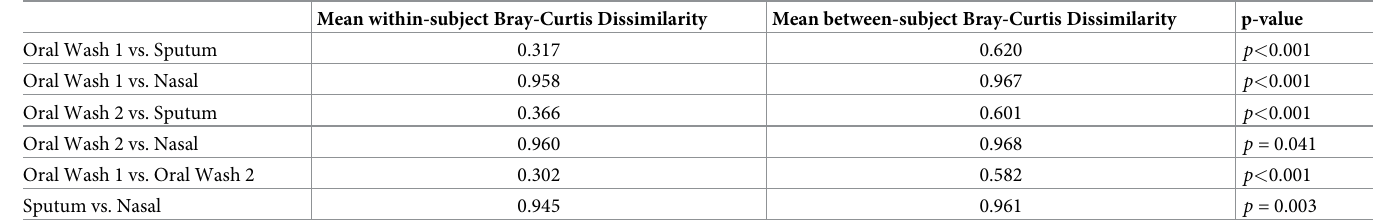
Table 2. Within- vs. between-subject sample